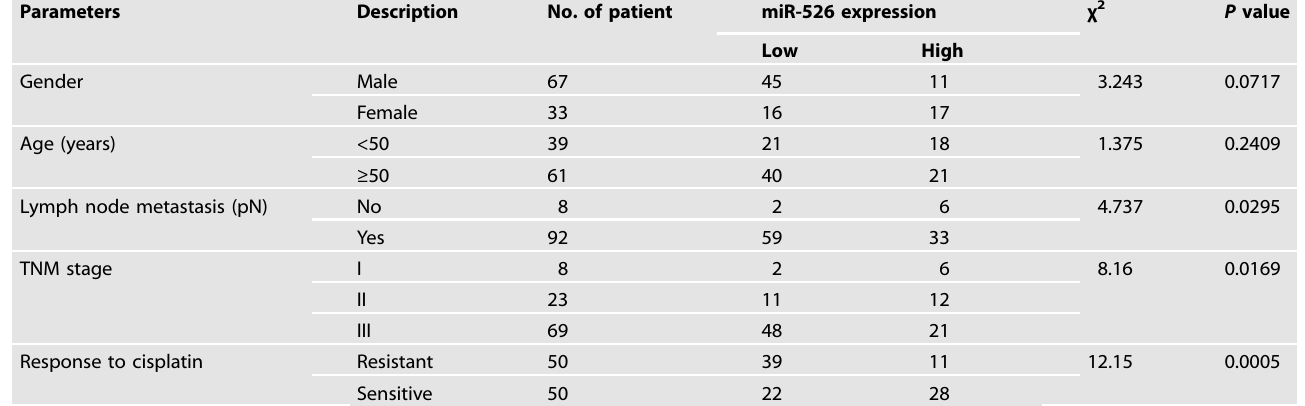
Table 1. The correlation between miR-526b-3p expression and pathological features of lung cancer. Parameters Description